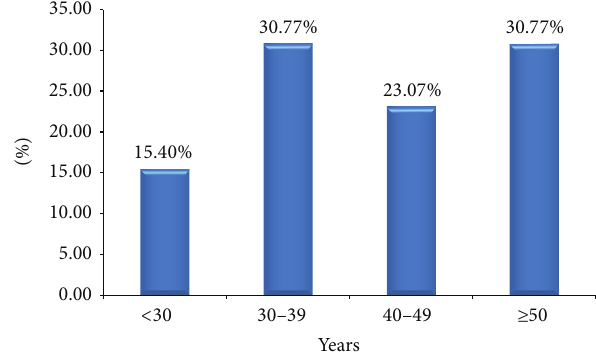
Figure 2: Distribution of diabetes mellitus among different age groups of patients in Debre Berhan Referral Hospital in June